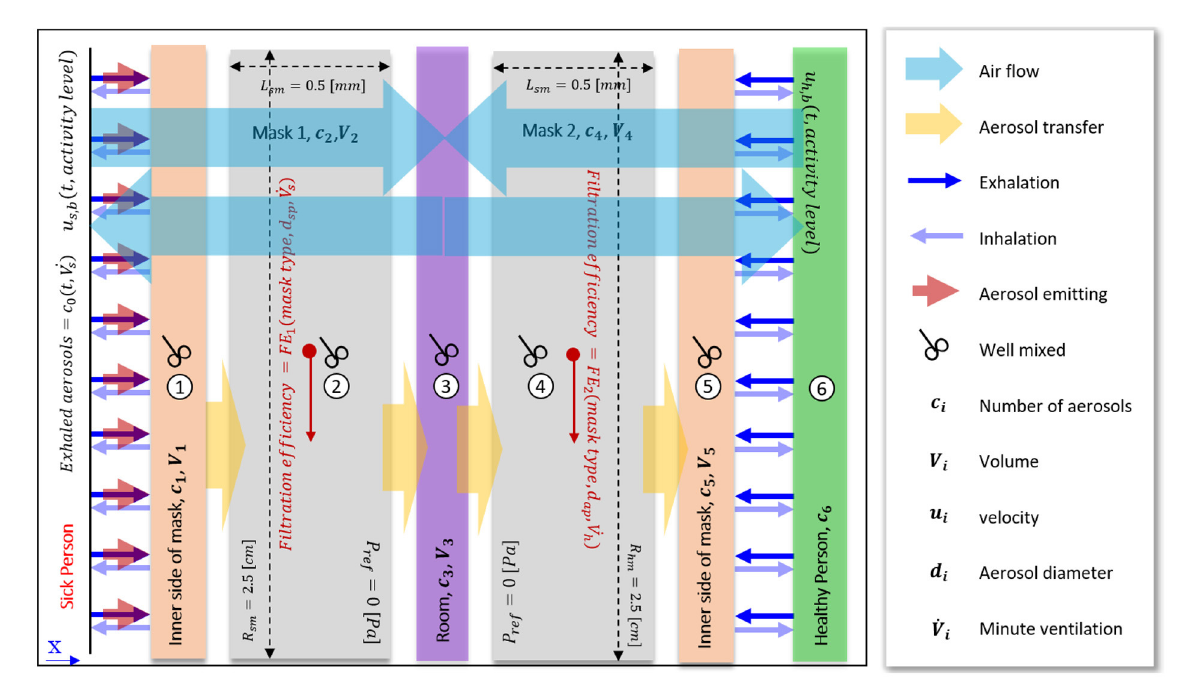
FIGURE3 Geometry and boundary conditions of the overall model for two people (infected and healthy people) in close contact. The modeled geometry consists of 6 zones: the zone between the respiratory airway and mask for the infected person; the mask of the infected person; the room in which these two people are meeting: the mask of the healthy person; the zone between the respiratory airway and mask for the infected person; and the inner airway of a healthy person.